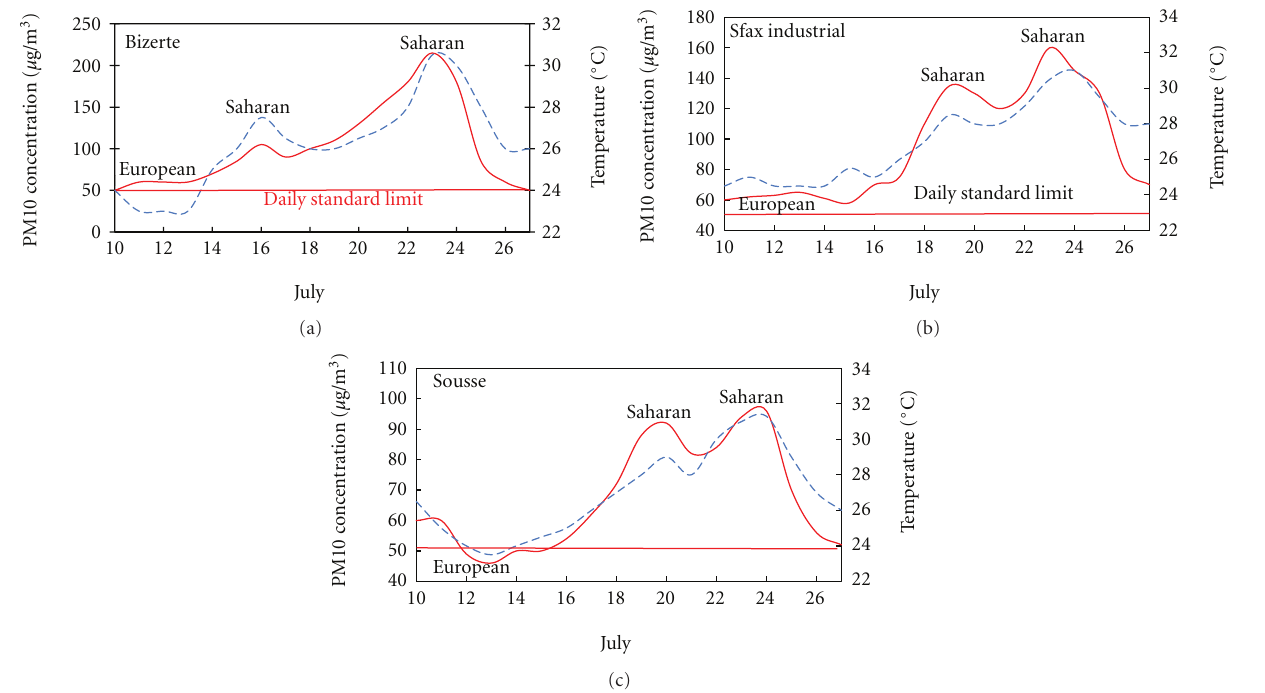
Figure 6: Daily variability of samples of the PM10 concentrations and temperature during summer in the selected monitoring stations. Time evolution of the left y axis is plotted with solid line, and the right one is plotted with dashed line. (Solid and dashed lines are smooth curve